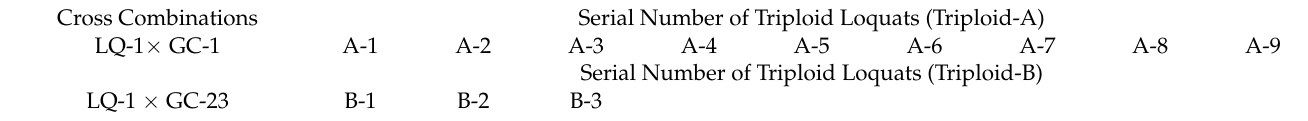
Table 4. The loquat materials in the two cross combinations used in this study. Cross Combinations Serial Number of Triploid Loquats (Triploid-A) LQ-1 × GC-1 A-1 A-2 A-3 Serial Number of Triploid Loquats (Triploid-B) LQ-1 × GC-23 B-1 B-2